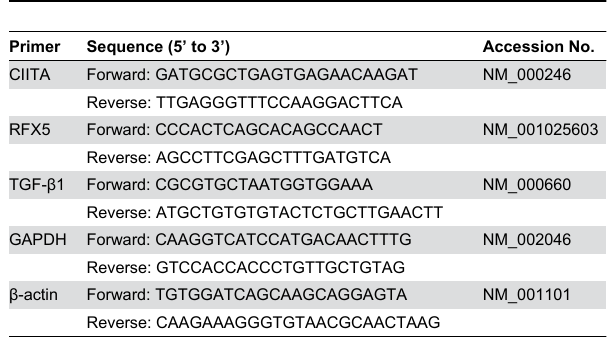
Table 1. Oligonucleotide sequences used in this study.